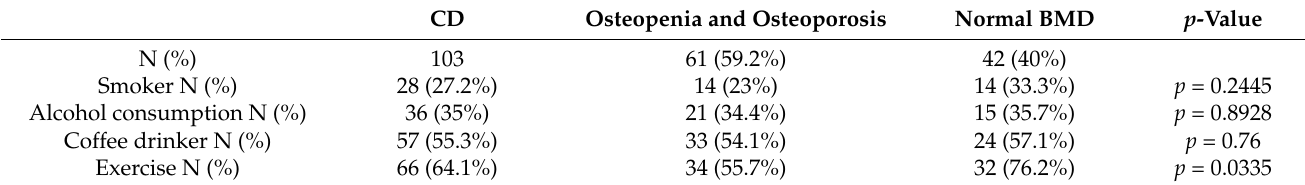
Table 6. The lifestyle parameters of the study CD patients with respect to osteoporosis and